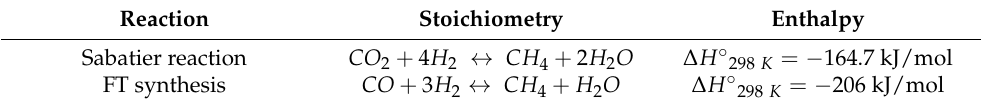
Table 25. Main reactions involved in the production of methane through CO 2